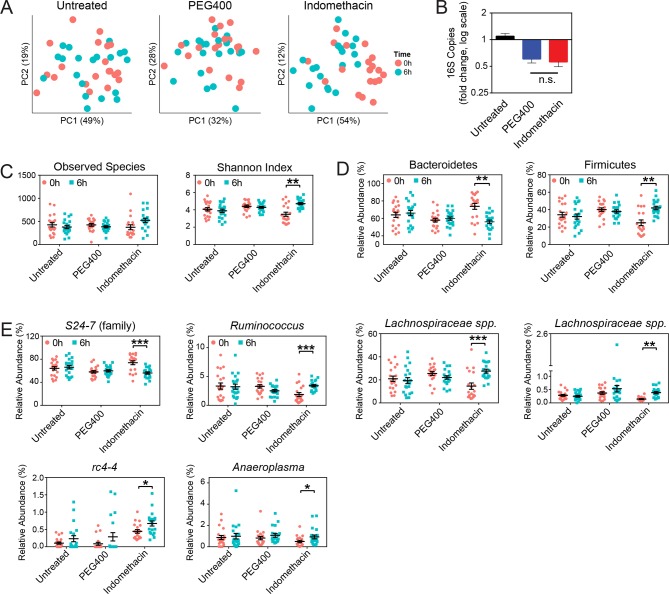
Indomethacin induces longitudinal changes in fecal microbiota composition.Microbiota composition in fecal pellets before (0 hr) and after (6 hr) treatment with or without indomethacin or PEG400 is analyzed by 16S rRNA gene profiling, including sequencing and quantitative PCR. (A) Principal coordinates analysis (PCoA) of weighted UniFrac values (Lozupone et al., 2011), comparing the fecal microbial communities at 0 hr (black) versus 6 hr (blue) of untreated (left), PEG400 (middle), and indomethacin (right) groups. Each point represents a sample. Fecal microbial communities at 0 hr and 6 hr are not separated in untreated group (p>0.5), and significantly clustered in PEG400 group (p<0.5) and in indomethacin group (p<0.01). Clustering was analyzed by ADONIS test. (B) 16S rRNA gene copies per gram of feces at 0 hr and 6 hr (left), and Fold changes (right) in indomethacin (red), PEG400 (blue), and untreated (black) groups. Both PEG400 and indomethacin groups have lower bacterial loads at 6 hr, whereas these are no between-group differences at 0 hr or 6 hr. ****p<0.0001 by Mann-Whitney test comparing 0 hr versus 6 hr. N=20/group. Mean ± S.E.M. shown. (C) Both Observed Species (left) and Shannon Index (right) are increased at 6 hr in indomethacin-treated mice, while unchanged in Untreated and PEG400 groups. **p<0.01 by multiple t test, FDR corrected. N=19–20/group. Mean ± S.E.M. shown. (D) The relative abundance of Bacteroidetes (left) is decreased and that of Firmicutes (right) is increased at 6 hr (blue) after indomethacin treatment. **p<0.01 by multiple t test, FDR corrected. N=19–20/group. (E) Indomethacin induced a decrease in the relative abundance of S24-7 (family), and increases in those of Ruminococcus, Lachnospiraceae sp., Lachnospiraceae sp., rc4-4, and Anaeroplasma at 6 hr (blue). *p<0.05, **p<0.01, ***p<0.001 by QIIME analysis, FDR corrected. N=19–20/group. Mean ± S.E.M. shown.